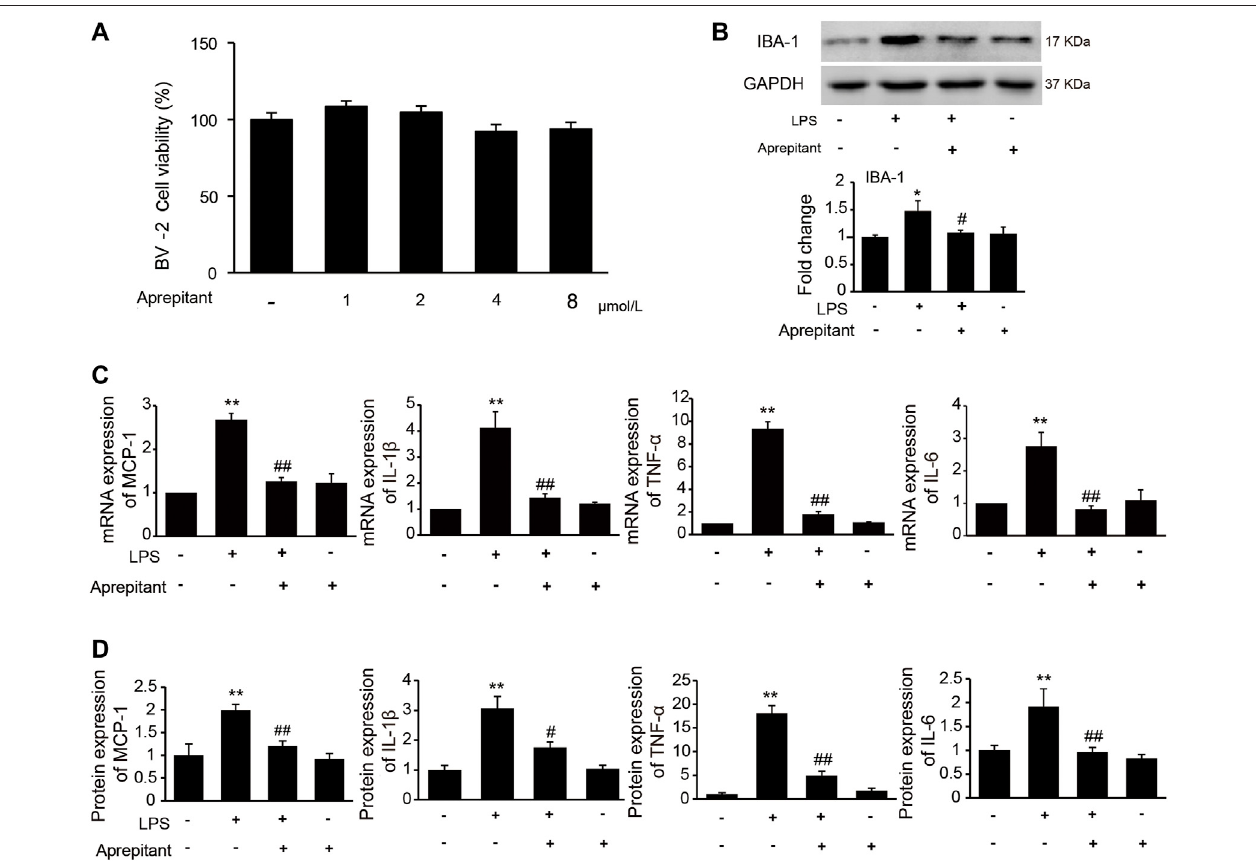
FIGURE 3 | Effect of aprepitant on lipopolysaccharide (LPS)-induced BV-2 microglial activation. (A) Cell viability was measured using an MTT assay. (B) The representativeimmunoblotsandgraphicrepresentationofrelativeexpressionofIBA-1. (C) ThemRNAexpressionofMCP-1,IL-1 β ,TNF- α andIL-6inBV-2microglia. (D) ELISA showed that aprepitant decreased the LPS-induced secretion of MCP-1, IL-1 β , TNF- α and IL-6 in BV-2 microglia ( n (cid:1) 6). Data are expressed as mean ± SEM. One-way ANOVA, * p < 0.05, ** p < 0.01 versus control, # p < 0.05, ## p < 0.01 versus